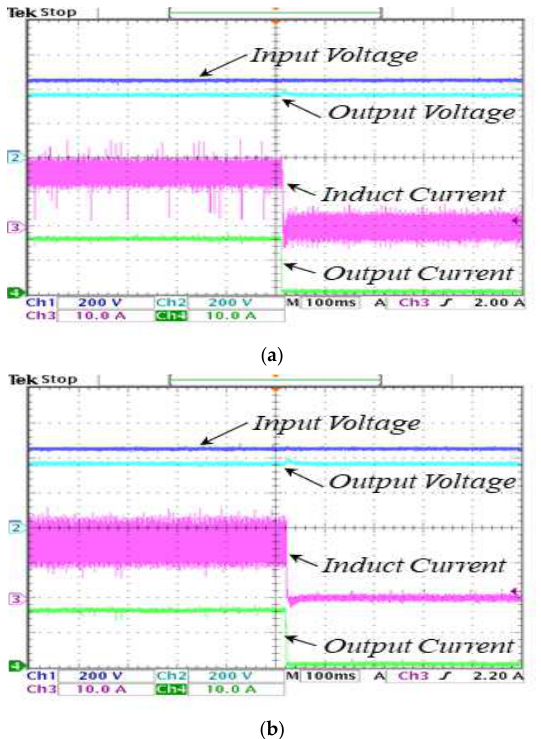
Figure 15. Comparison of load variation characteristic test. ( a ): Experimental results of conventional converters. ( b ): Experimental results of the proposed converter.